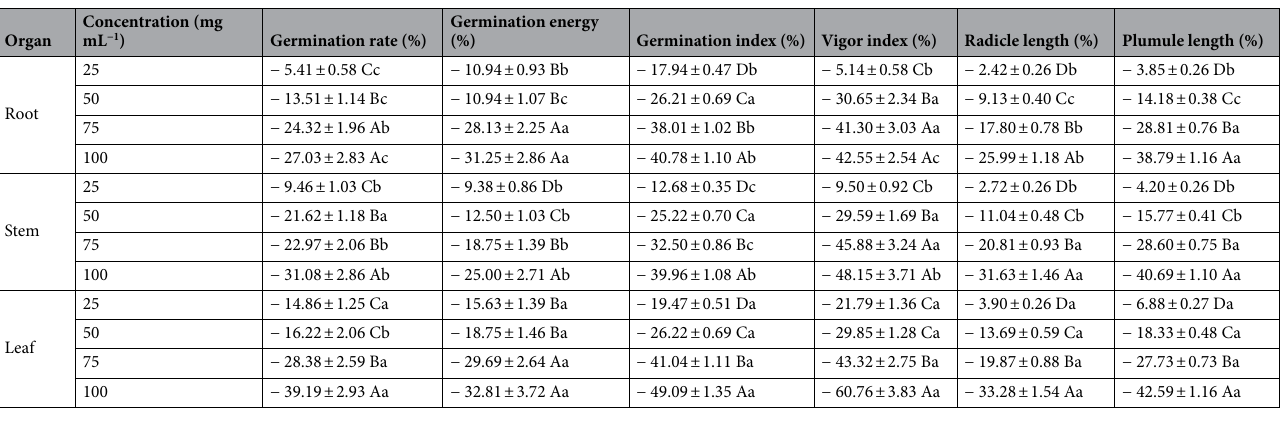
Table 3. Effects of different aqueous extracts of sesame on the allelopathic index. Different capital letters of the same organ in the same column indicated significant differences among different concentrations at P < 0.05 level, and different lowercase letters of the same concentrations in the same column indicated significant differences among different organs at P < 0.05 level.